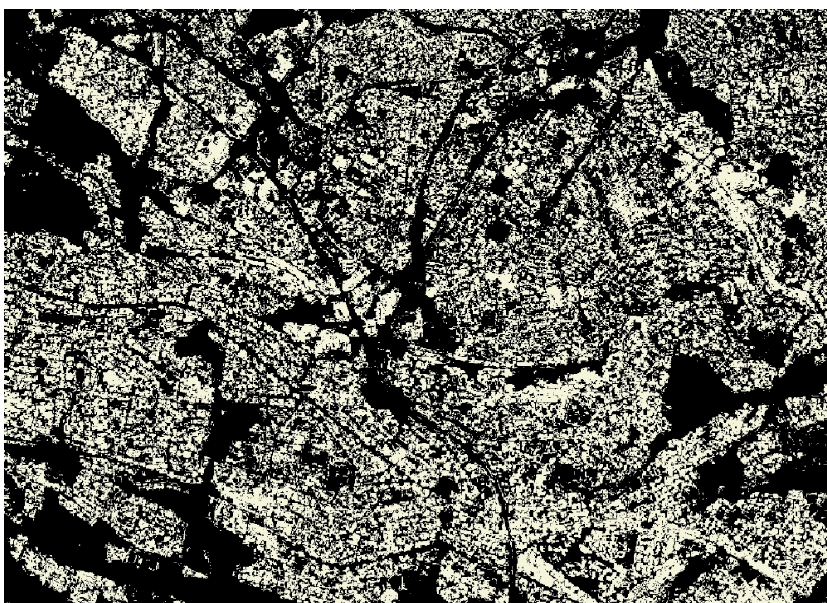
Figure 10. Human settlements layer for Johannesburg, South Africa from SPOT 6.